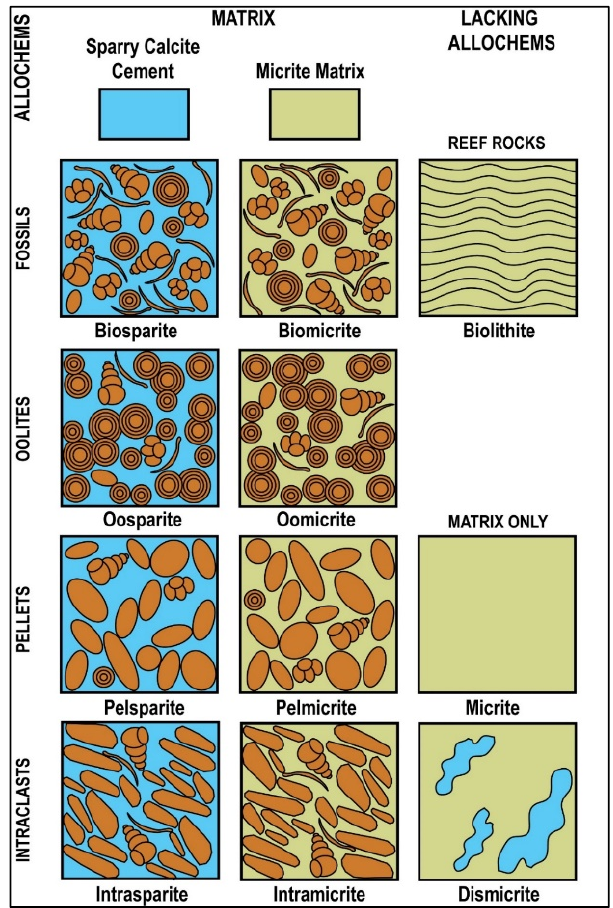
Figure 1. Representing the Folk classification of limestone, based on alluvial micrite matrix and sparry calcite cement.